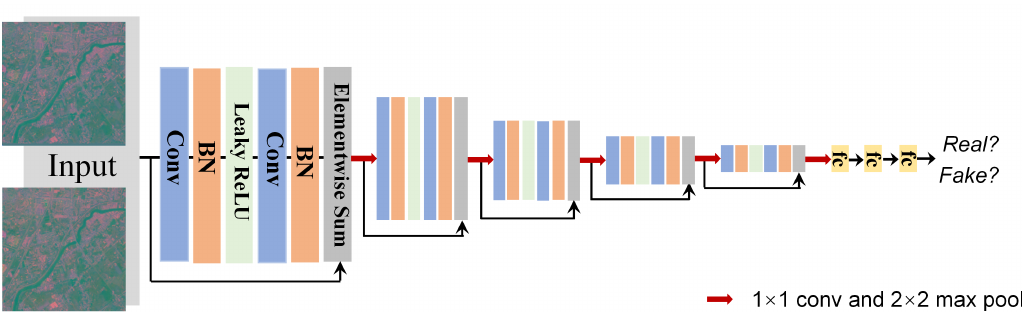
Figure 5. Architecture of